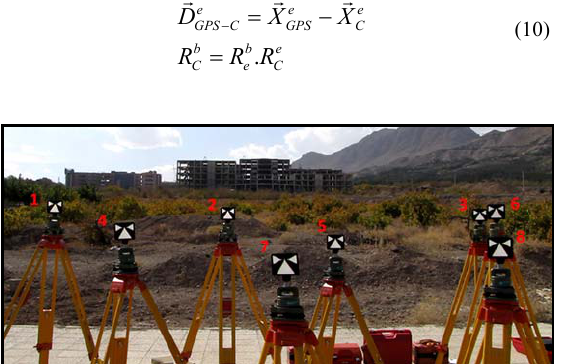
Figure 2. The pre-installed targets to calibrate the platform